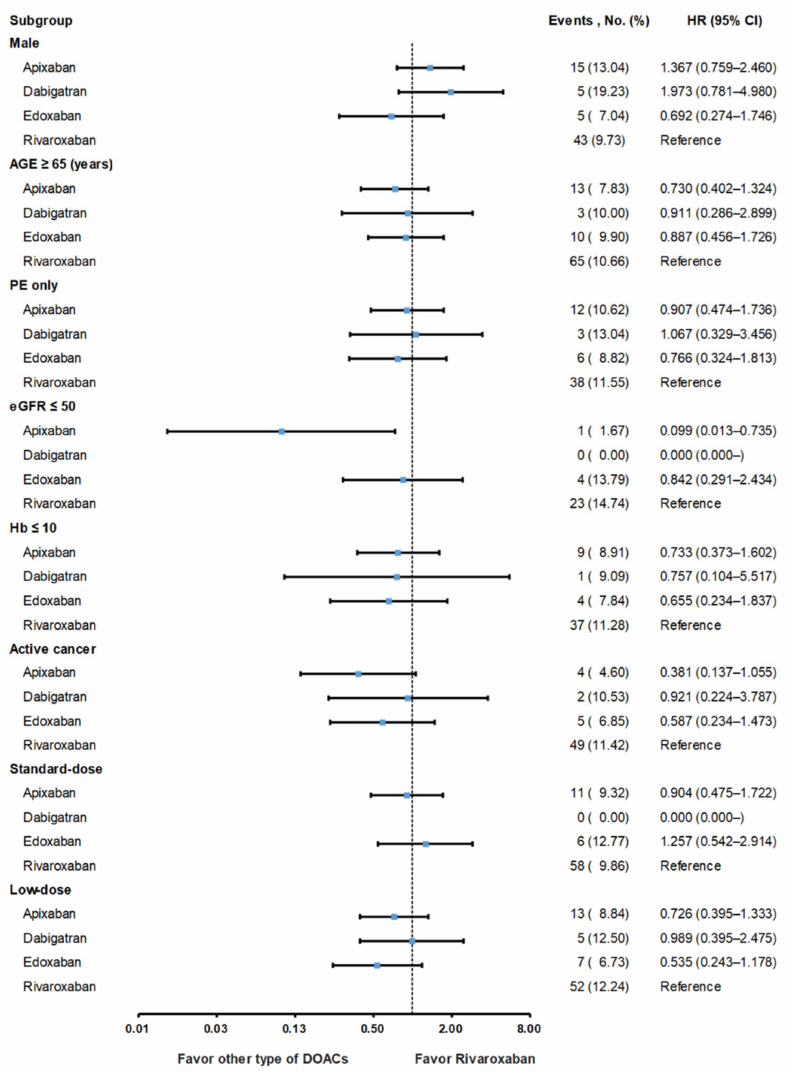
Figure 3. Subgroup analysis for detecting the composite outcomes of recurrent VTE and major bleeding in patients treated with different DOACs. DVT, deep vein thrombosis; eGFR, estimated glomerular filtration rate; Hb, hemoglobin; DOACs, direct oral anticoagulants; PE, pulmonary embolism; VTE, venous